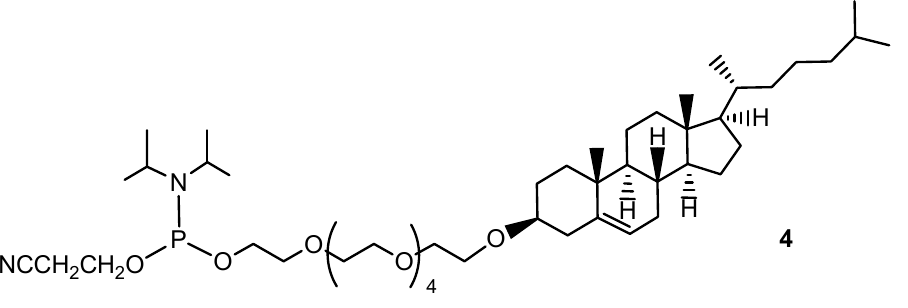
Figure 2. Chemical structure of the herein synthesized phosphoramidite derivative 4 .